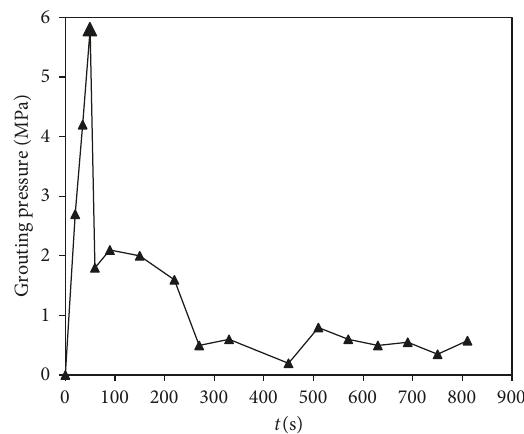
Figure 6: Double grouting pressure over time for Test C.